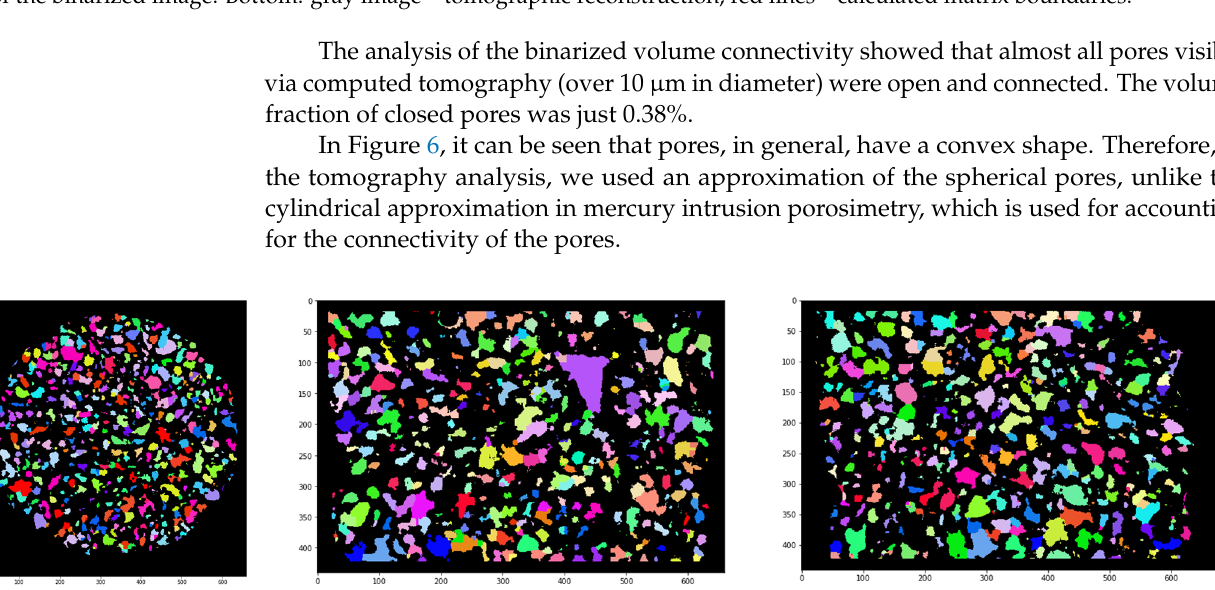
Figure 5. Example of binarization shown on three orthogonal reconstruction layers. Above: three-dimensional visualization of the binarized image. Bottom: gray image—tomographic reconstruction, red lines—calculated matrix boundaries.